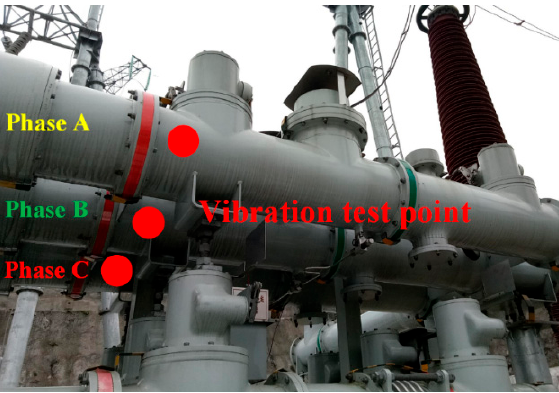
Figure 16. The location of the vibration measuring point.